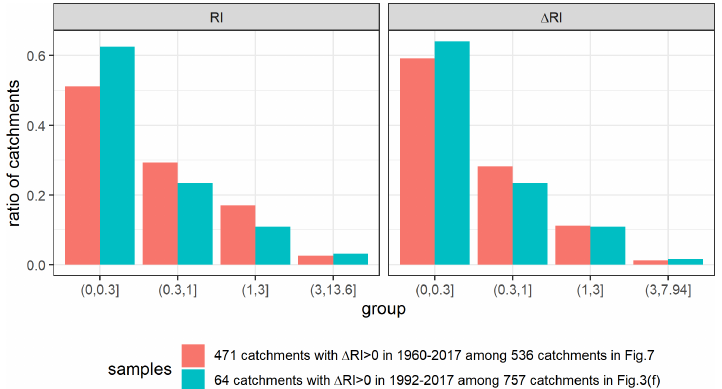
Figure A3. Frequency distribution of RI and (cid:49) RI in catchments with (cid:49) RI > 0 from two catchment sets: the one used for the regression in Fig. 3f (green) and the one used for the flood change attribution in Fig. 7